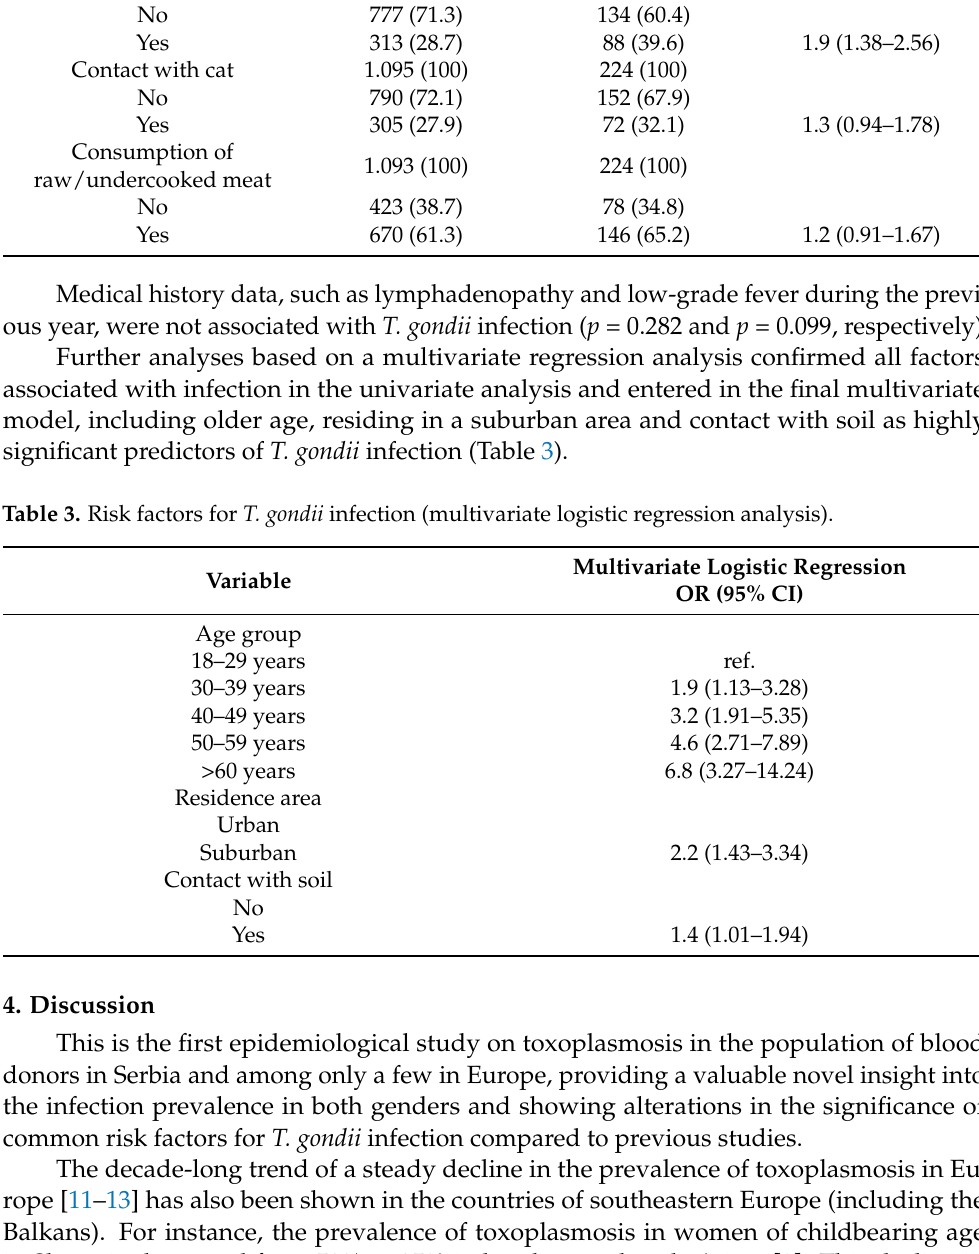
Lifestyle Habits